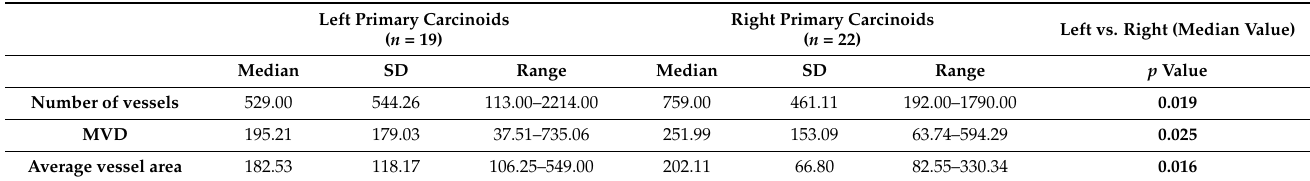
Table 2. Angiogenesis determined by IHC expression of CD34-positive cells in terms of number of vessels, MVD and average vessel